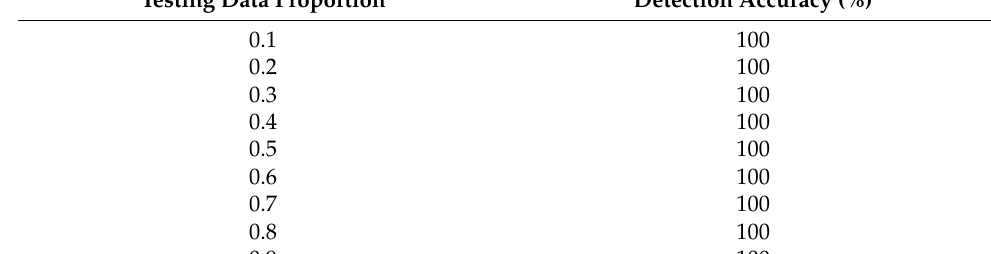
Table 4. Fault detection accuracy.